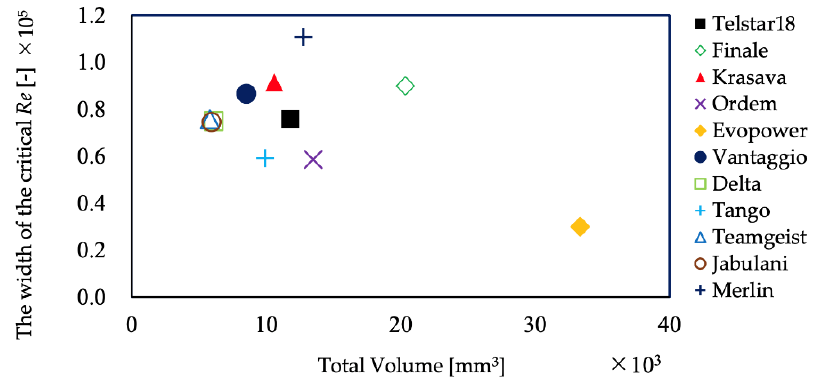
Figure 11. The relationship between the width of the critical region and total groove volume.